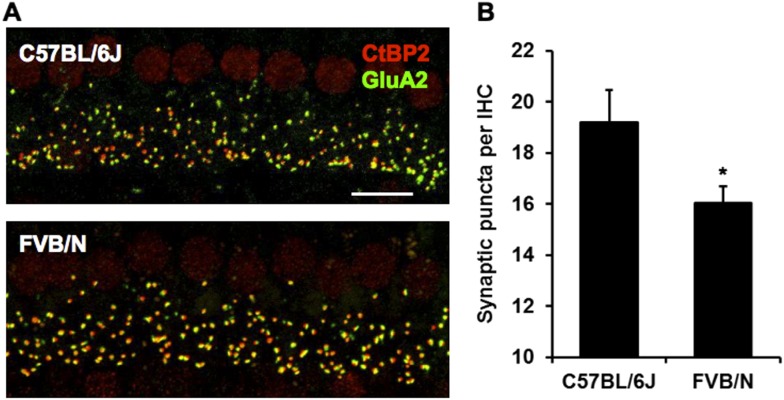
Ribbon synaptic density of C57BL/6J and FVB/N mouse strains. (A) Representative confocal images (maximal projection from a focal series) of IHC synapses from 32 kHz region of 8 wk-old C57BL/6J and FVB/N cochleae immunolabeled for pre-synaptic ribbons (CtBP2-red) and post-synaptic receptor patches (GluA2-green) (scale bar = 10 µm). (B) Synaptic counts of C57BL/6J and FVB/N cochleae at 32 kHz; n = 4-6. *p<0.05 by unpaired student’s t-test.